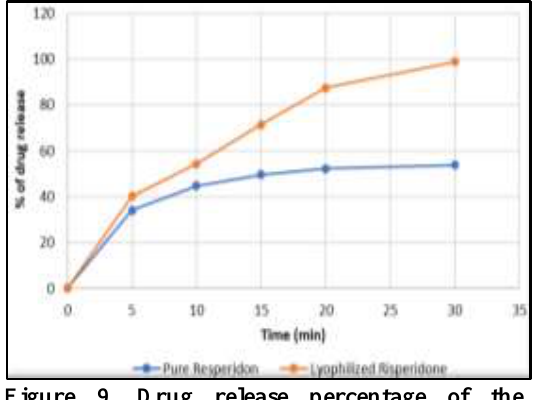
Figure 9. Drug release percentage of the lyophilized risperidone Differential scanning calorimetry